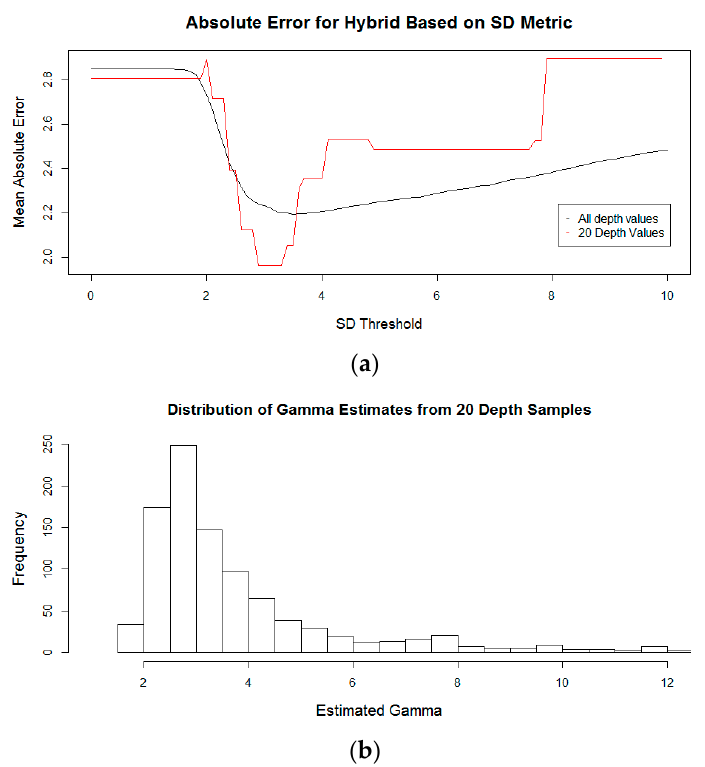
Figure 12. ( a ) Plot of the mean absolute errors for the combined bathymetry vs. the SD threshold, all depth values (black trace) with a typical plot of the mean absolute errors for the combined bathymetry vs. the SD threshold using 20 random values (red trace). ( b ) Histogram of 1,500 estimates of ϓ from 20 samples of ground truth depth.